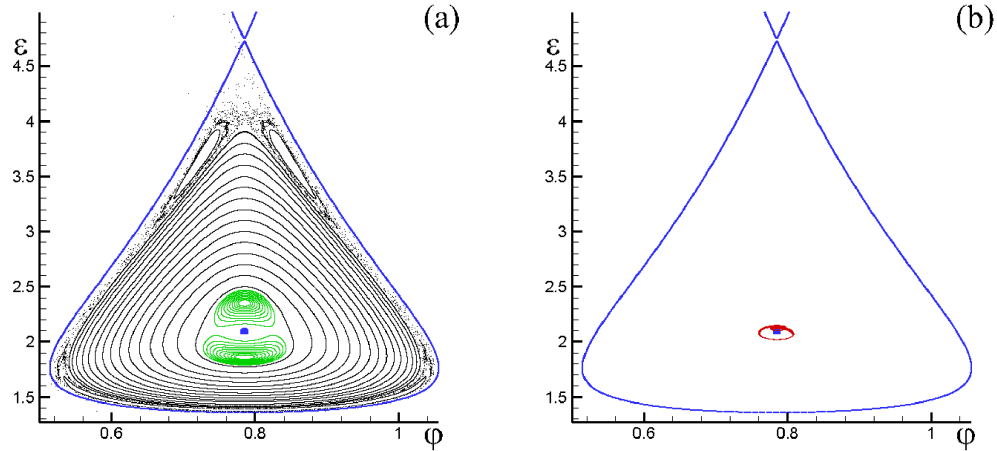
Figure 3. The dynamics of the perturbed system in the case of the primary parametric instability zone of the corresponding linearized system (Eq. 7) for e 0 = 0 . 15, γ 0 = 0 . 02 and perturbation parameters δ = 0 . 01, ν = 0 . 6. The solid blue lines show the steady-state separatrix. The blue dot shows the steady-state elliptic critical point ϕ 0 = π/ 4, ε 0 ≈ 2 . 09244. Panel (a) shows a Poincaré section illustrating the appearance of a highly nonlinear zone (the green orbits) near the steady-state elliptic critical point that prohibits the divergent motion due to the linear parametric resonance; (b) a phase trajectory starting at the steady-state elliptic critical point bounded to the region of the nonlinear resonance, illustrating a vanishing effect of the linear parametric resonance.